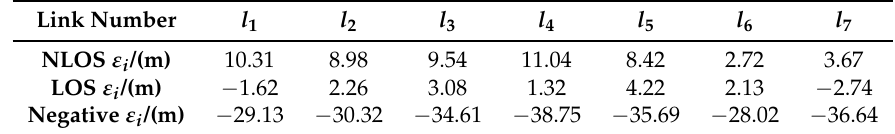
Table 3. Ranging errors in the cooperative